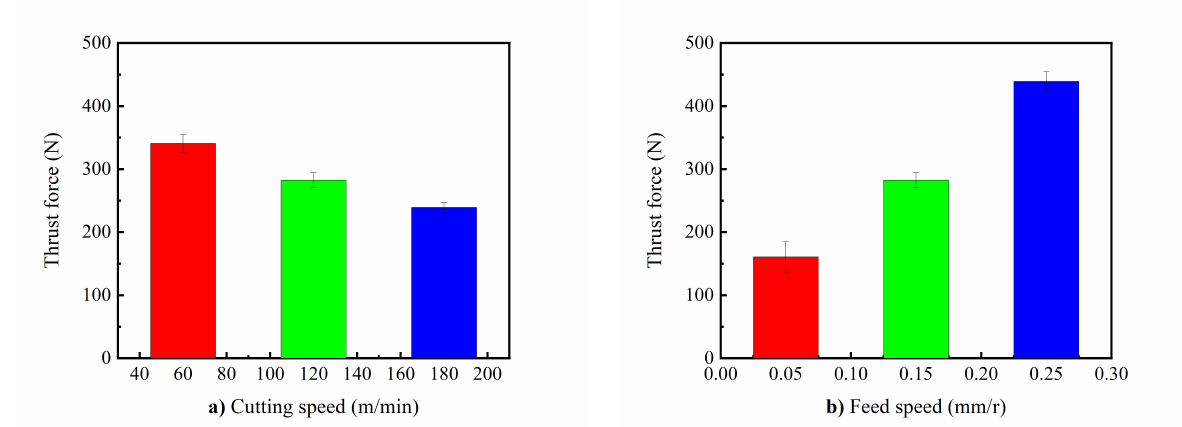
Fig. 5. Effect of the v c and f on the thrust force